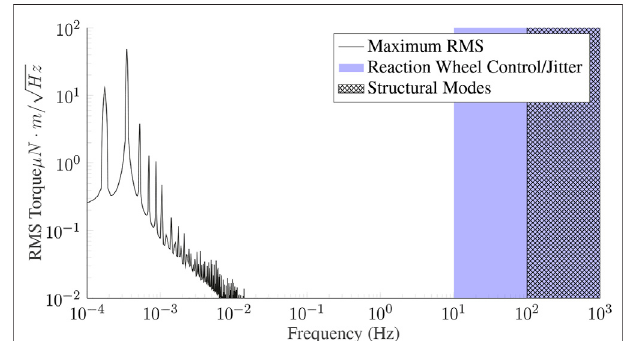
FIGURE 2 | Frequency content of perturbation torques on a small satellite in low-Earth orbit. Disturbances are due to atmospheric drag, solar radiation pressure, and a gravity gradient. The disturbances manifest on the left as a solid curve representing the maximum value from an ensemble of orbits drawn from multiple years of credible low-Earth orbits. On the far right, solid shading illustrates typical actuator-induced error frequencies, and hatching represents typical nanosatellite structural